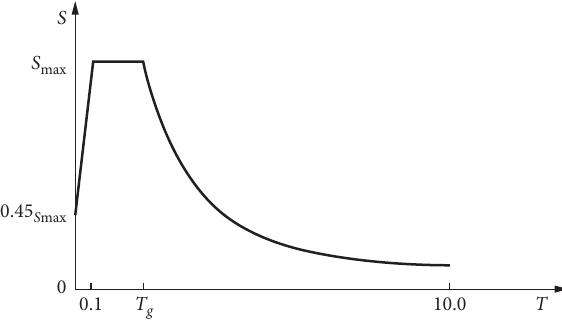
Figure 17: Design response spectrum curve in the horizontal direction. Table 3: Sum of mass coefficients of mode participation.